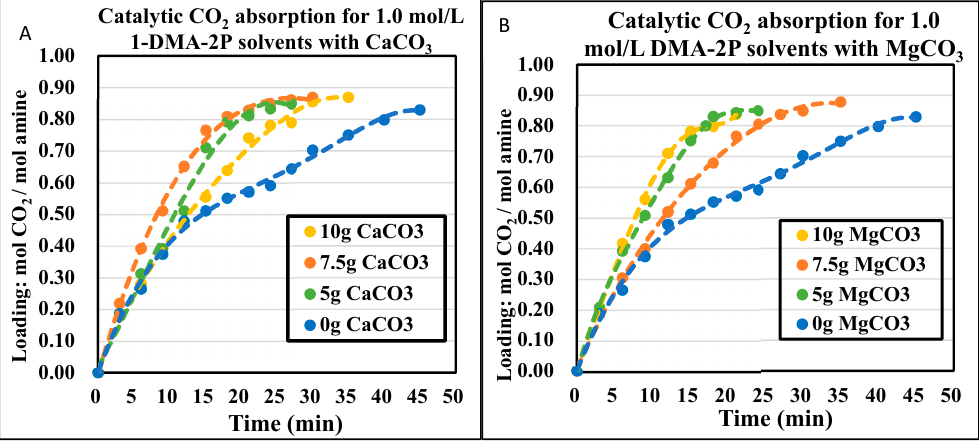
Figure 5. Catalytic CO 2 absorption curves of 1.0 mol/L 1DMA-2P solvents at 293 K and 1 atm. ( A ). CaCO 3 0–10 g. ( B ). MgCO 3 0–10 g.